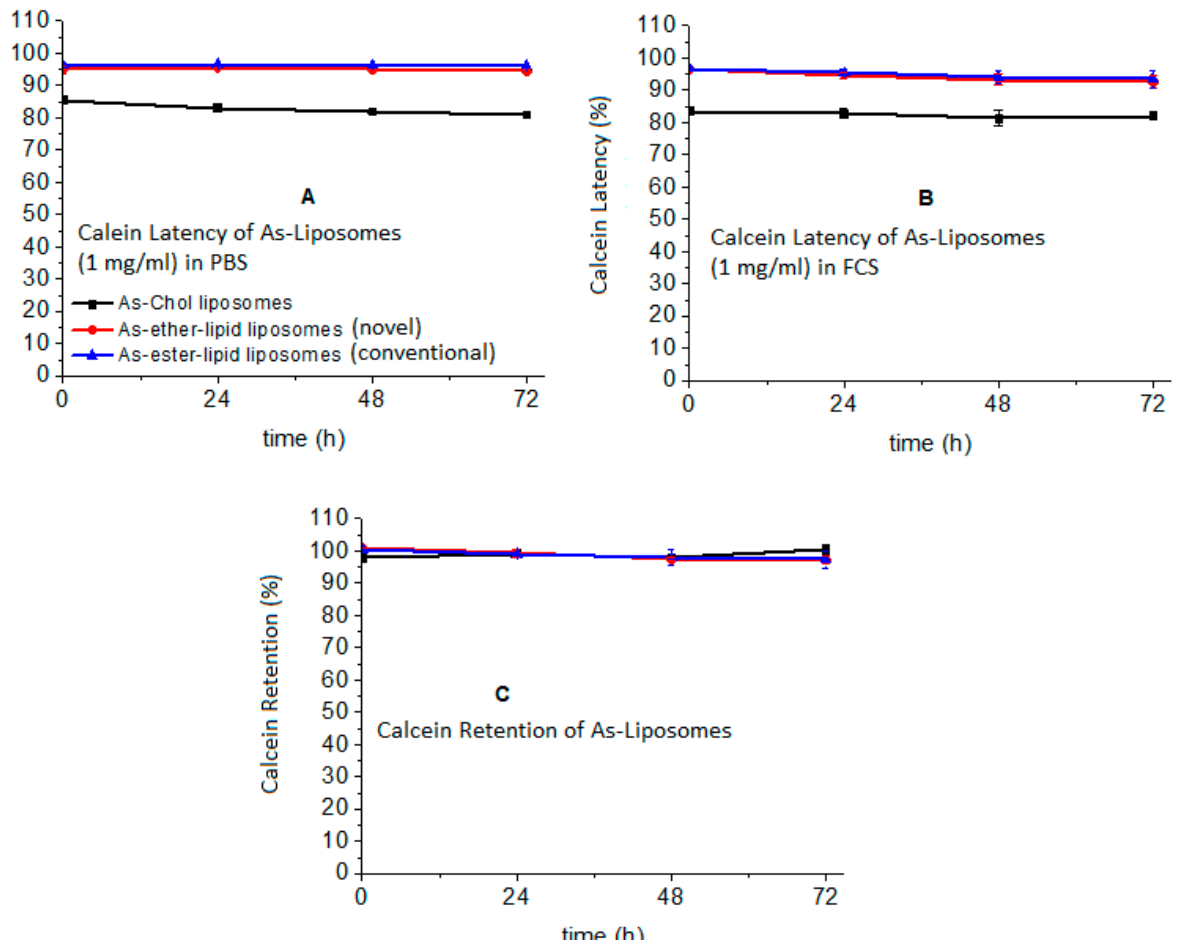
Figure 5. Calcein latency (%) in PBS ( A ) and FCS ( B ) as well as calcein retention (%) in vesicles containing As-ether-lipid 27 or As-Chol 32 (novel arsonoliposomes) during incubation at 37 ◦ C ( C ). The previously synthesized As-ester-lipid liposomes of type 2 (conventional liposomes) were evaluated under identical conditions for